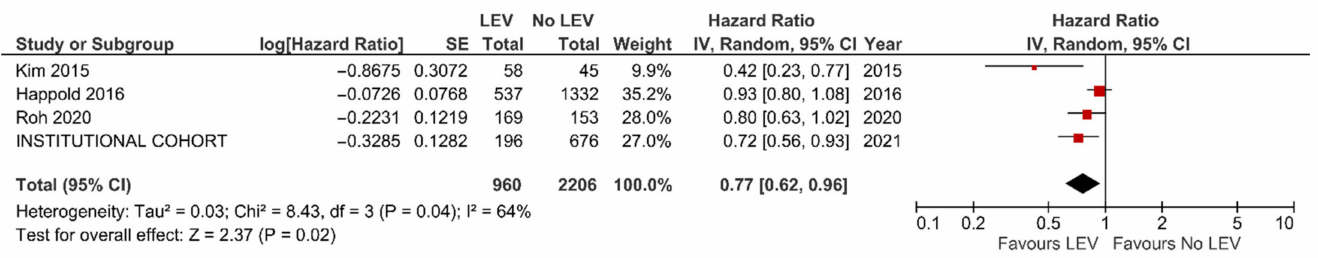
Figure 4. Meta-analysis of studies reporting on PFS of GBM patients with and without LEV